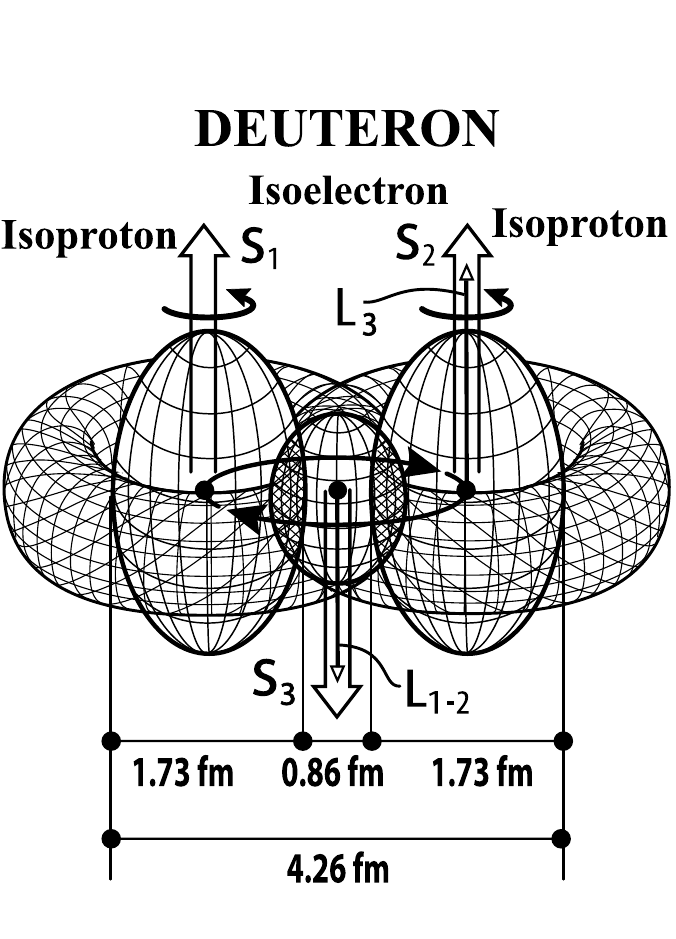
Figure 16: A conceptual rendering of the deuteron model (91) illustrating the represen- tation for the first time of spin J = 1 with angular momentum L = 0 , where: the D D two isoprotons have the charge diameter D = 1 . 73 fm ; the deuteron has the charge ˜ p diameter D = 4 . 26 fm ; the interspace between the isoprotons is then of 0 . 86 fm ; the D isoelectron has a point-like charge, the hadronic diameter D hm = 1 fm , and a semi- ˜ e classical wavepacket with D cl = 2 . 2 fm . The above data illustrate the stability of model ˜ e (81) with the central isoelectron allowing the isoprotons in the triplet coupling needed to achieve the spin J = 1 in the true ground state (Figure 14). The doughnuts around the D two isoprotons are used to represent the proton-neutron exchange